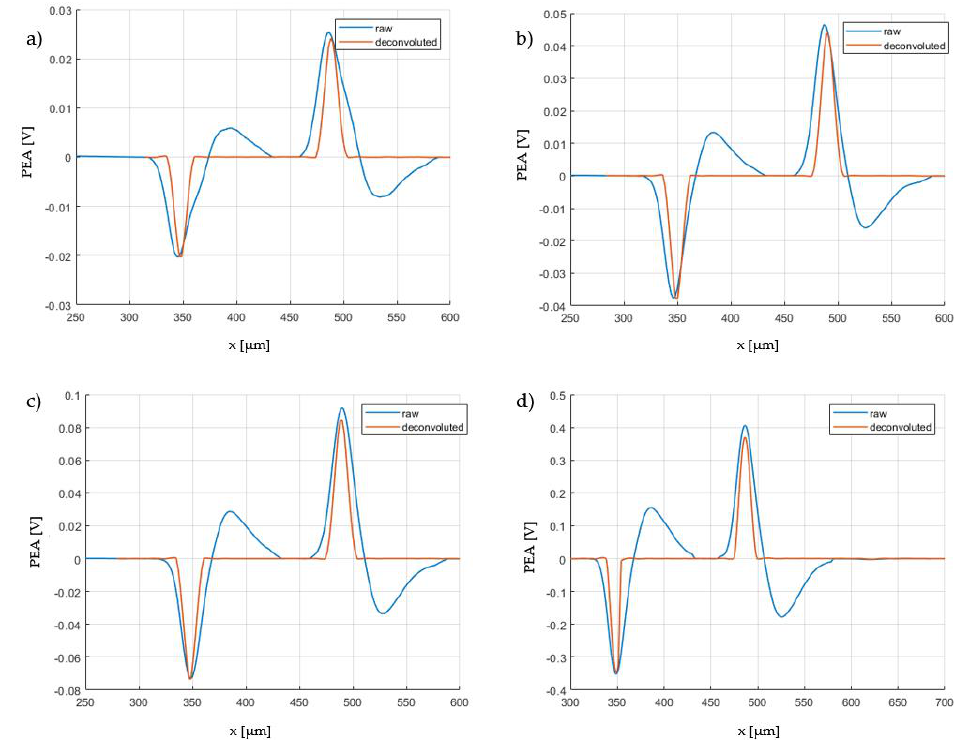
Figure 5. Space charge profile in Kapton HN ® d = 0.15 mm sample measured for different pulser widths t w , sensor d s = 9 µm, UHVDC U = 2 kV, raw signal, and after deconvolution, pulser t r = 1 ns, widths t w , sensor d s = 9 µ m, UHVDC U = 2 kV, raw signal, and after deconvolution, pulser t r = 1